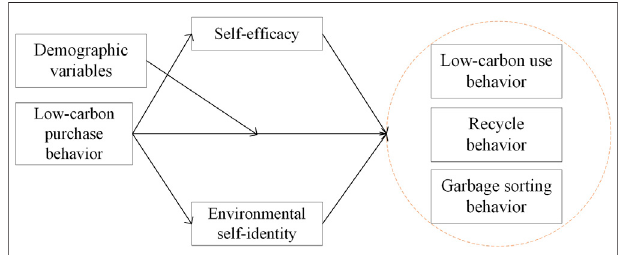
FIGURE 1 | Conceptual model